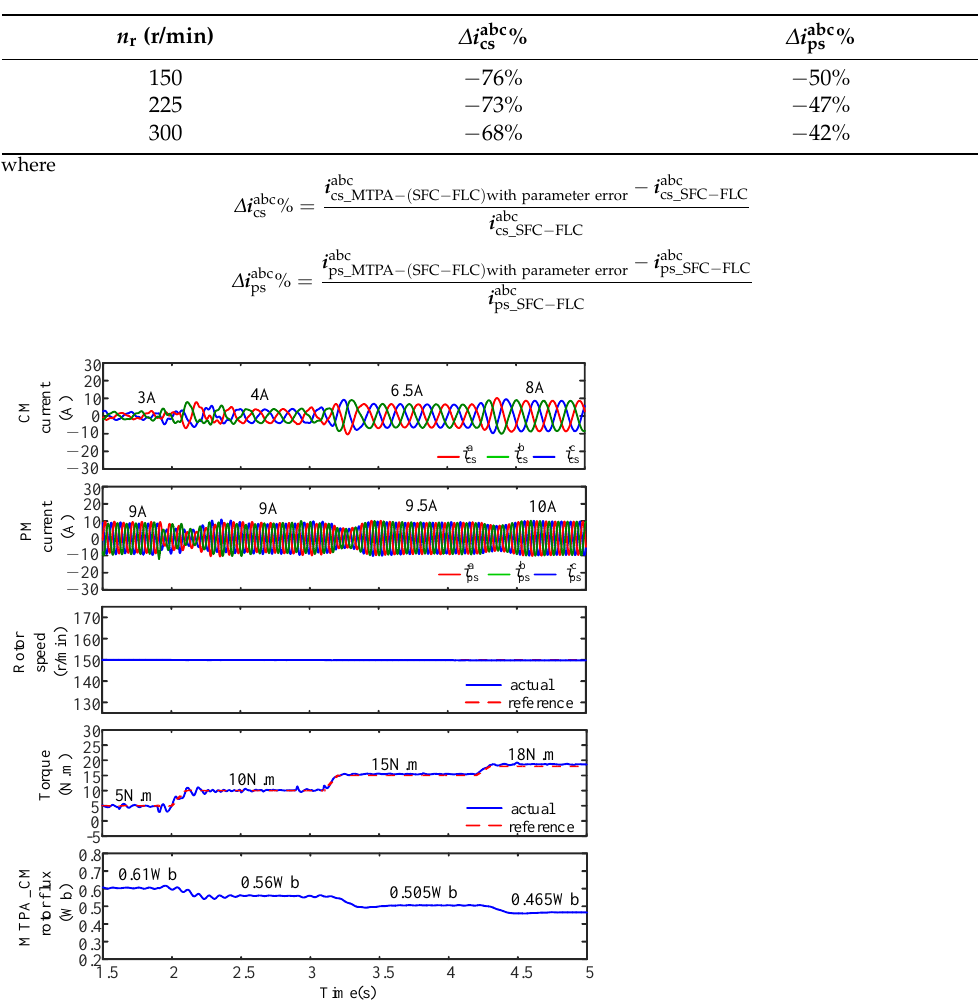
Figure 14. The comparison data of the simulation experiment of the MTPA-(SFV-FLC) control algo- rithm with and without parameter deviation at different torques. Table 5. When there is a deviation in the parameters, the current comparison of the two control methods of MTPA-(SFV-FLC) and (SFV-FLC) at different torques. T e (N.m)